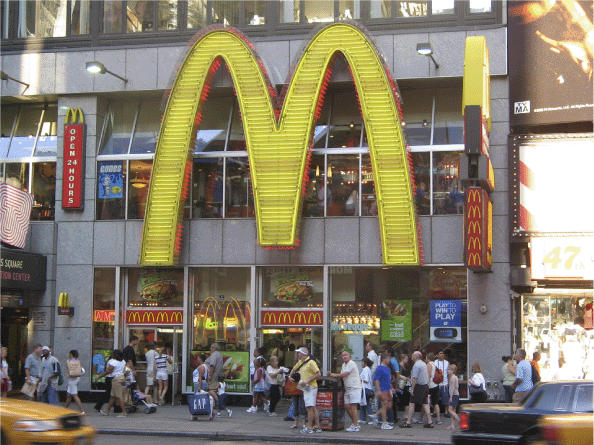
Kelly Brownell has suggested that the marketing and advertising techniques of the corporate food industry play a role in the rise in obesity